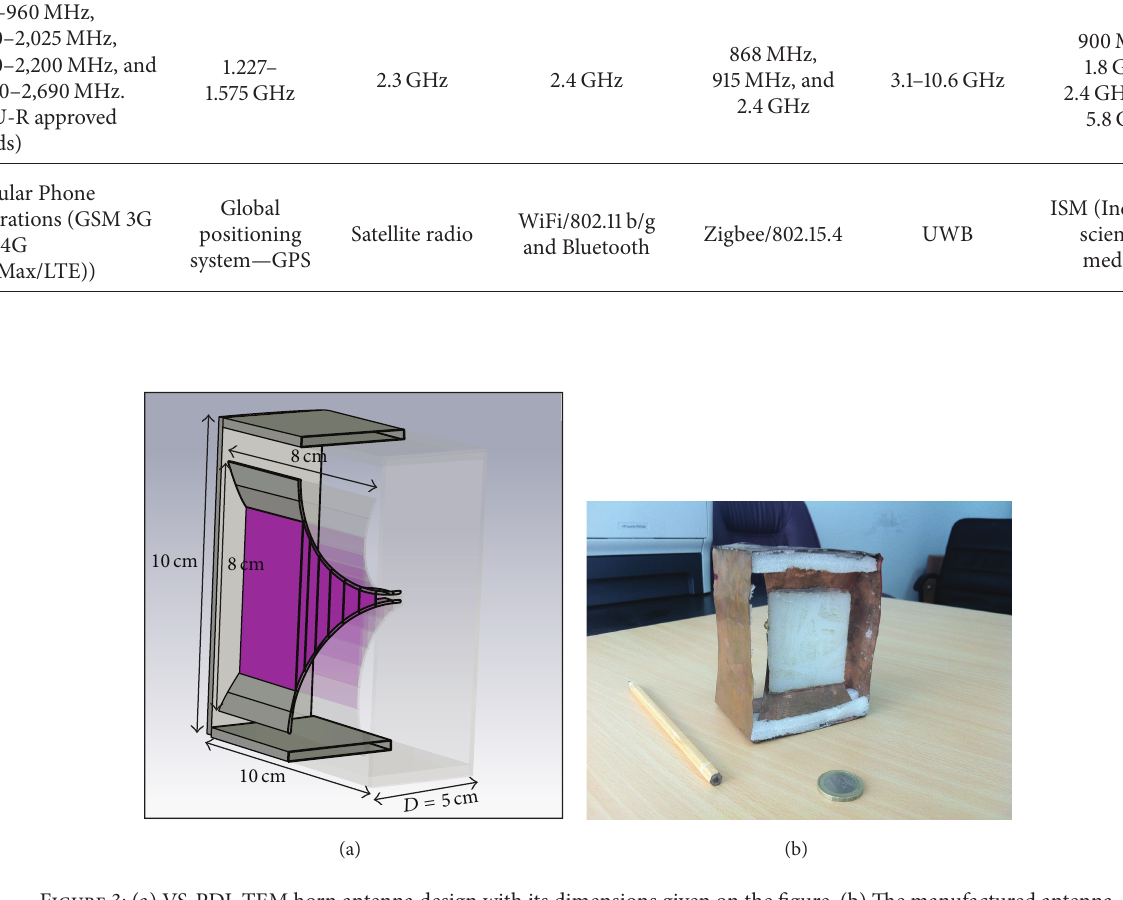
is given in Figure 3(a) as vertically divided right-hand- side made transparent for the purpose of clarity while the manufactured antenna is shown in the Figure